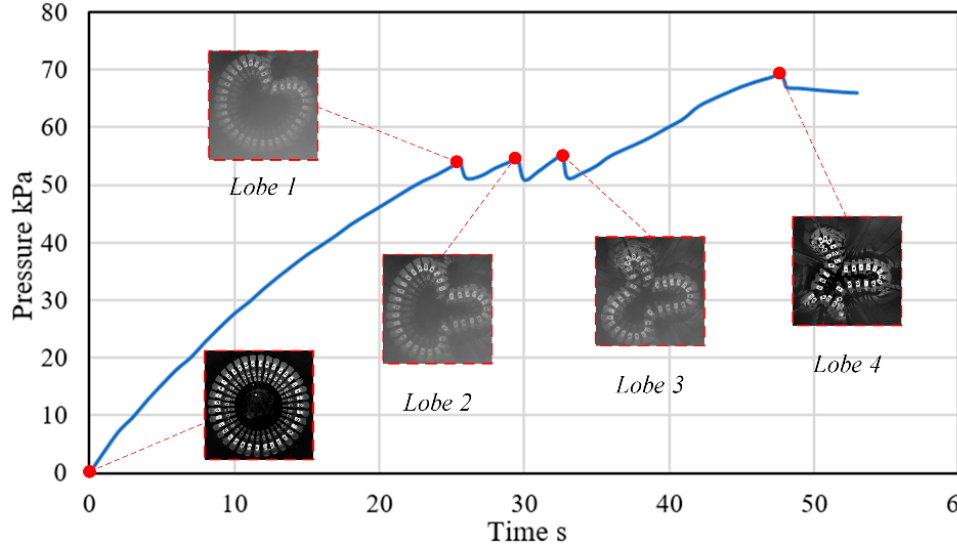
Figure 7. Typical post-buckling pressure curves.